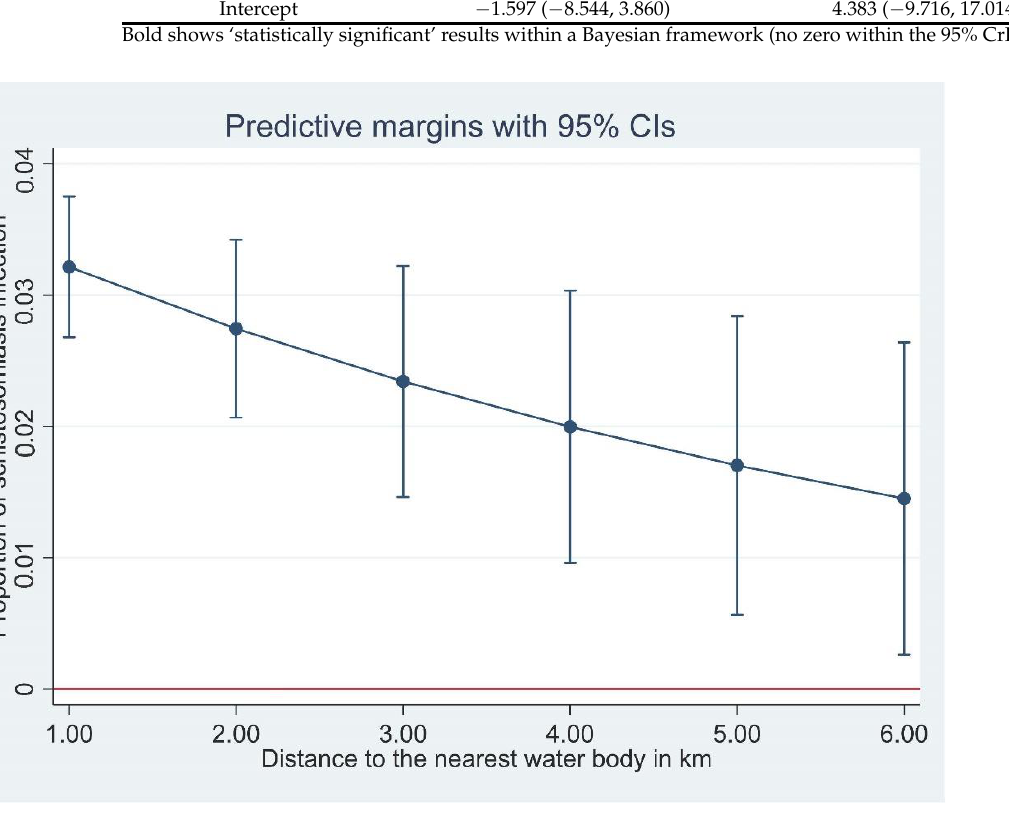
Figure 3. The proportion of Schistosoma japonicum infection with distance of household to the nearest waterbody, derived from a logistic regression model. Table 4. Regression coefficient mean and 95% credible intervals (CrI) of covariates included in a Bayesian spatial model with Binomial response for the prevalence of schistosomiasis.